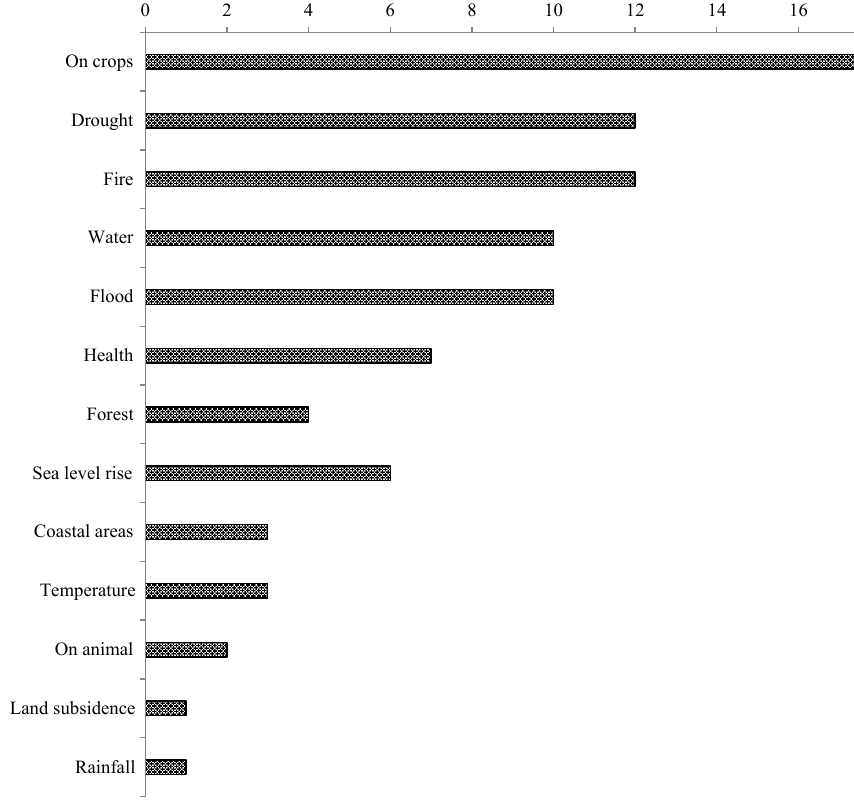
Figure 4. Key topics in the CC category on impacts of climate